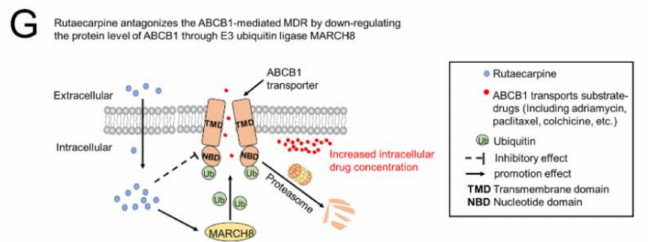
Figure 8. Potentiation of the antitumor effects of adriamycin/paclitaxel by rutaecarpine in the xenograft mice injected with parental or drug-resistant cells. ( A ) Tumor size, the photograph of xenografts was taken on the 20th day after implantation. Ctrl, control; Rut, rutaecarpine; ADM, adriamycin; PTX, paclitaxel. ( B ) Changes in tumor volume with time after different cells’ inoculation. Data shown are means SD for each group of three mice (* p < 0.05, ** p < 0.01). ( C ) The average tumor weight of each group was calculated after the tumors were resected from mice. Various treatments were given as follows: PBS (q2d); adriamycin/paclitaxel (15 mg/kg, i.p. q2d); rutaecarpine (15 mg/kg, i.p. q2d); rutaecarpine (15 mg/kg, i.p. q2d) and adriamycin (15 mg/kg, i.p. q2d)/paclitaxel (15mg/kg, i.p. q2d). Data shown are means SD for each group of three mice (* p < 0.05, ** p < 0.01). ( D ) Changes in body weight after cell inoculation. Data shown are means SD for each group of three mice after implantation. ( E , F ) The expressions of ABCB1 and MARCH8 were detected by immunohistochemical staining (scale bar, 500 µ m). ( G ) The working model of rutaecarpine.